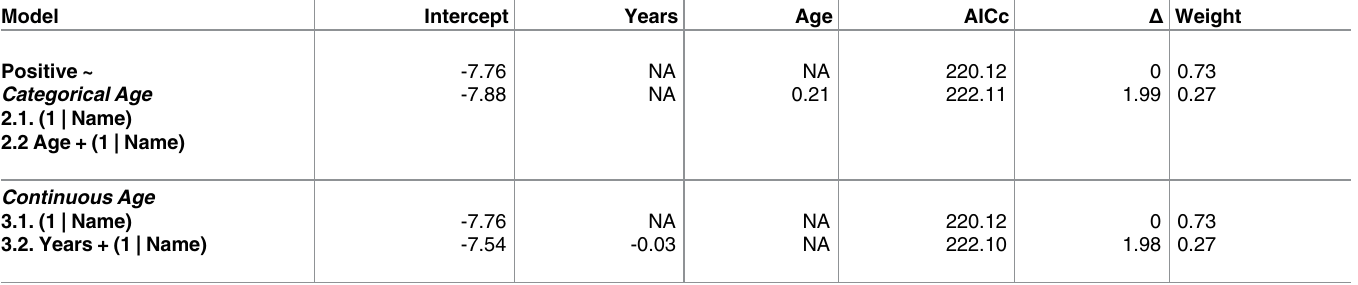
Table 4. AICc model selection for predictors of T . serialis antigen-positivity in gelada urine.